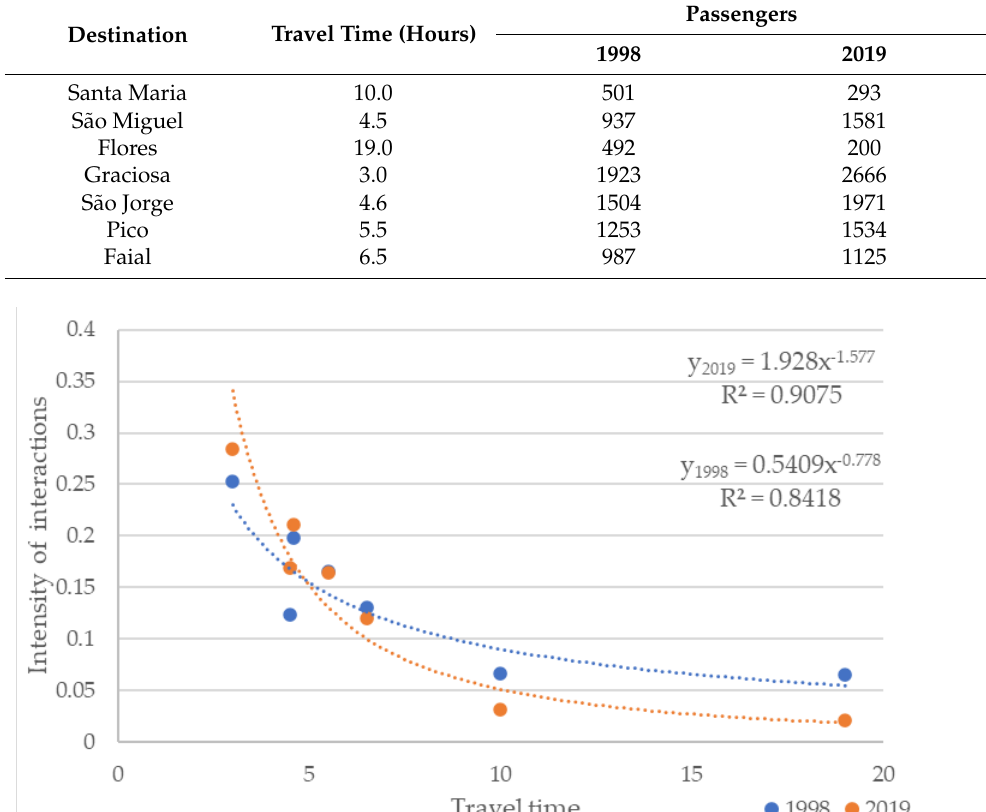
Figure 7. Intensity of interactions and travel time to Terceira Island from the rest of the archipelago— for 1998 and 2019.